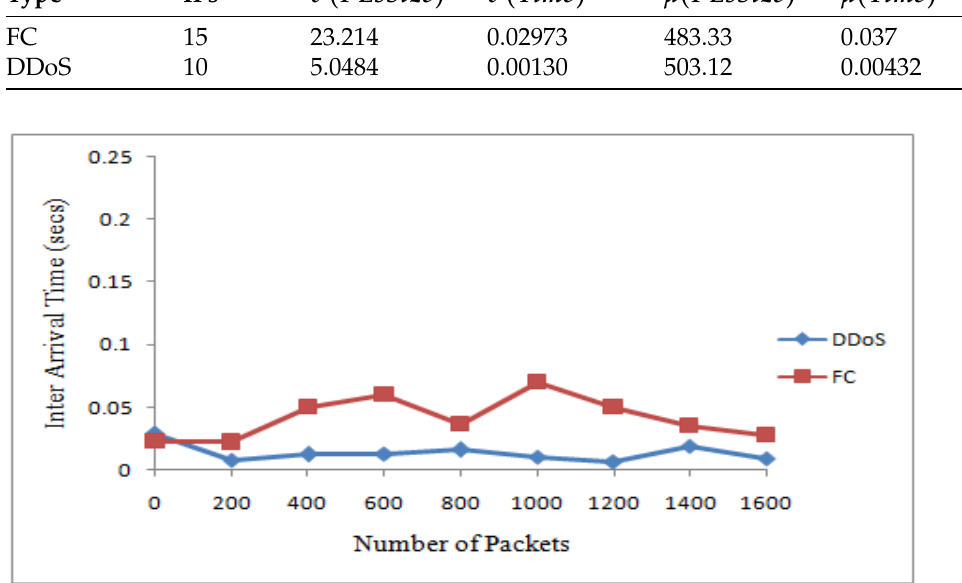
Figure 7. Discrimination of DDoS attack from FC based on